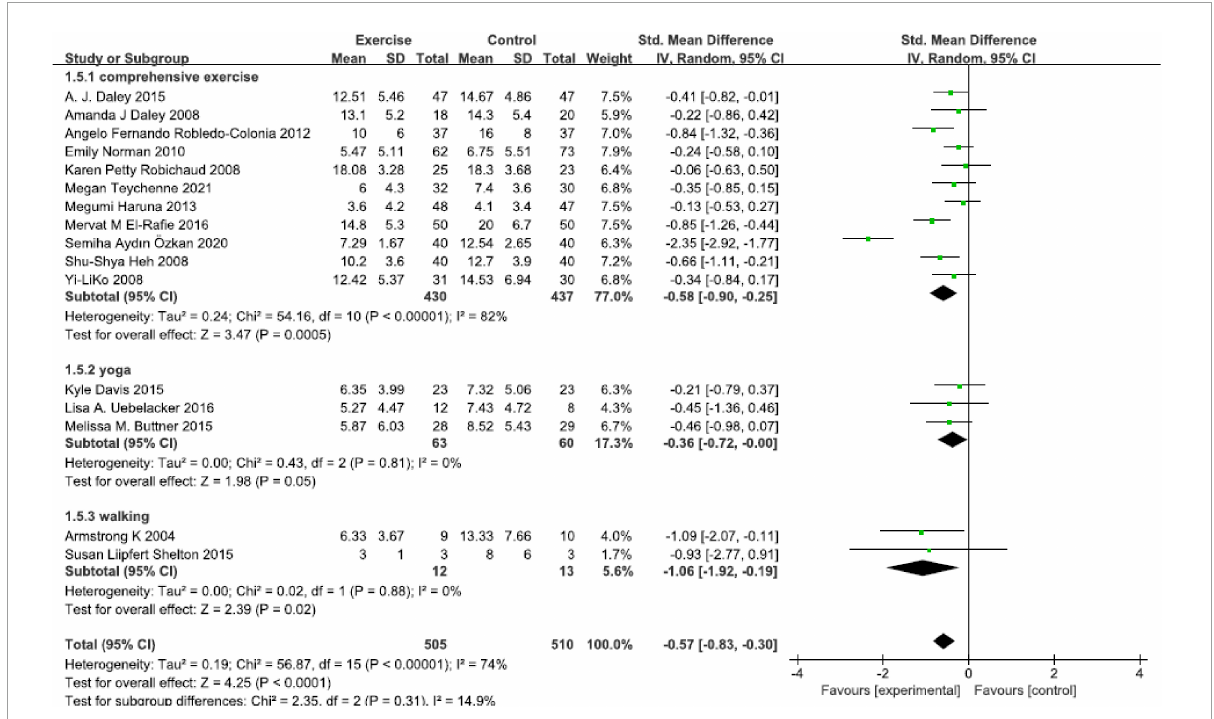
FIGURE4 Forest plot of the perinatal depression symptoms scores at different physical exercise intervention types.